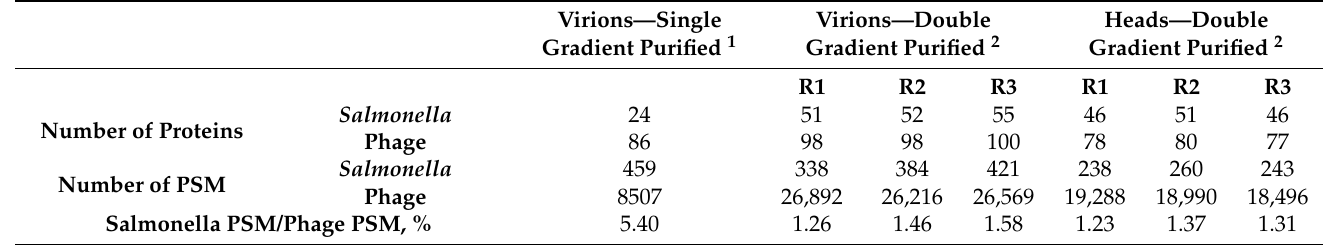
Table 1. Total numbers of Salmonella and SPN3US proteins and mass spectra identified in dual gradient purified virions and